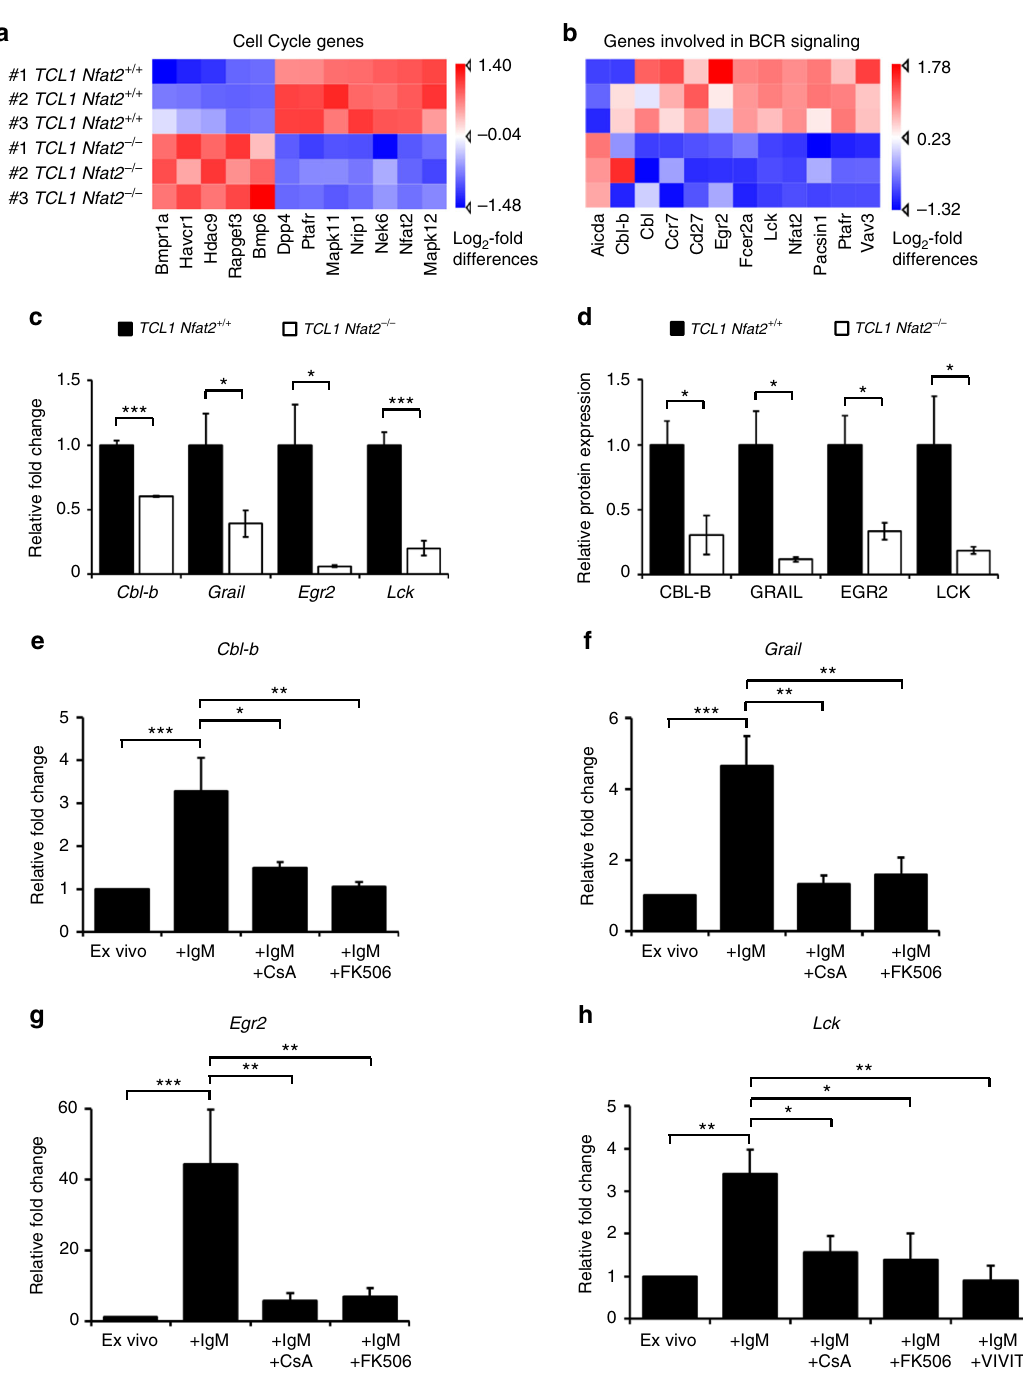
Fig. 5 NFAT2 regulates the expression of multiple anergy-associated genes in CLL. a , b Microarray analysis of FACS-sorted splenic CD19 + CD5 + CLL cells from 20-week-old TCL1 Nfat2 +/+ and TCL1 Nfat2 − / − mice ( n = 3 per group). Log 2 -fold differences of gene expressions are displayed in a hierarchical normalised heat map analysis which reveals changes in the expression of multiple cell cycle genes a and genes involved in BCR signalling b . c Relative gene expression of Cbl-b , Grail , Egr2 and Lck mRNA normalised to Actin expression in ex vivo splenic CLL cells from 20-week-old TCL1 Nfat2 +/+ and TCL1 Nfat2 − / − mice ( n = 5 per group) assessed by qRT-PCR (Student ’ s t -test, Mean ± S.E.M., * P < 0.05; *** P < 0.005). d Quanti fi cation of protein expression of splenic CLL cells from 20-week-old TCL1 Nfat2 +/+ and TCL1 Nfat2 − / − mice for CBL-B ( n = 4), GRAIL ( n = 3), EGR2 ( n = 3) and LCK ( n = 6) assessed by western blotting (Student ’ s t -test, Mean ± S.E.M., * P < 0.05). e – g Splenic CLL cells from 20-week-old TCL1 Nfat2 +/+ mice were isolated and stimulated in vitro with 10 µ g/ml α IgM, 10 µ g/ml α IgM + 1 µ M CsA or 10 µ g/ml α IgM + 1 µ M FK506 for 6 h. Relative mRNA expression of Cbl-b ( n = 4) f , Grail ( n = 3) g and Egr2 ( n = 5) h were assessed by qRT-PCR and normalised to Actin (One-way analysis of variance (ANOVA), Mean ± S.E.M., * P < 0.05, ** P < 0.01, *** P < 0.005). h Splenic CLL cells from 20-week-old TCL1 Nfat2 +/+ mice ( n = 5) were isolated and stimulated in vitro with 10 µ g/ml α IgM, 10 µ g/ml α